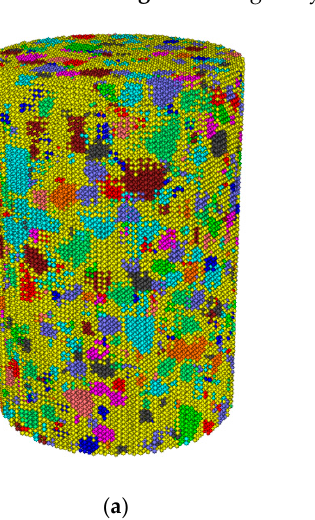
Figure 4. Irregularly shaped polyhedron aggregates.